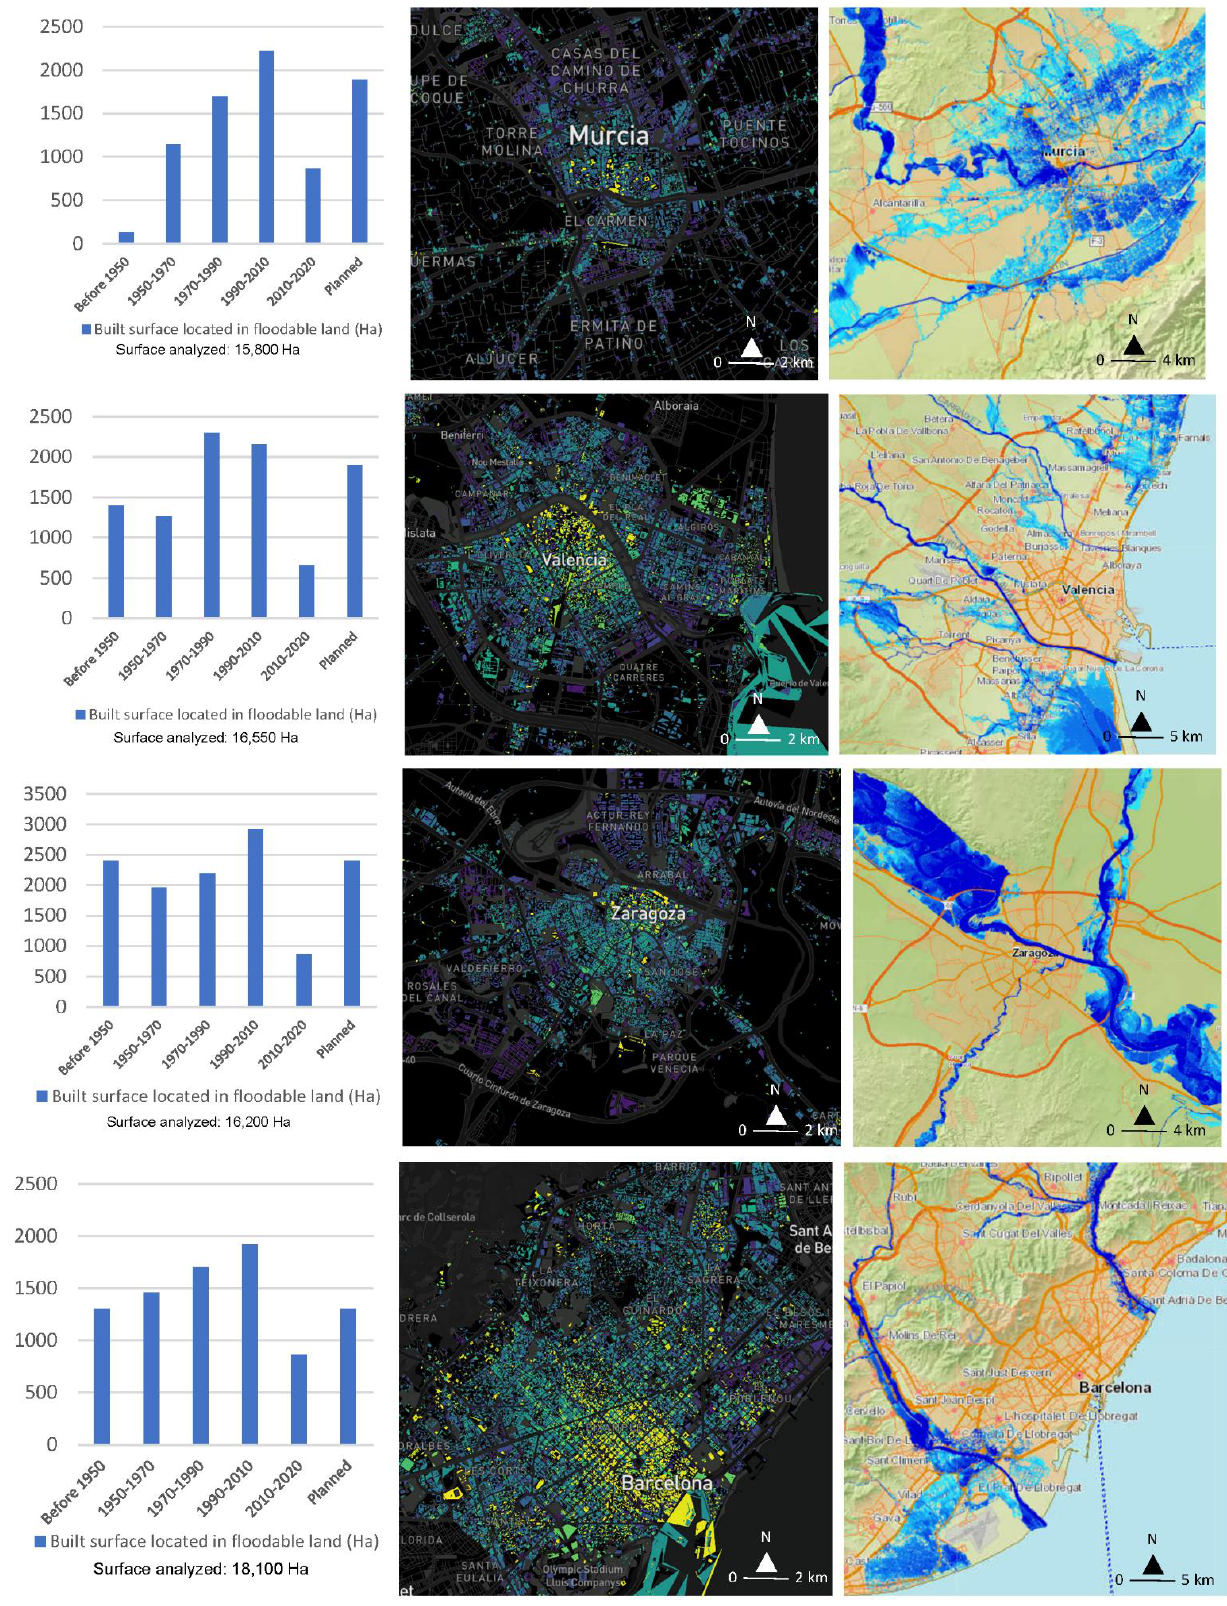
Figure 12. Temporal evolution of the urbanized vs. flooded areas in Murcia, Valencia, Zaragoza and Barcelona.